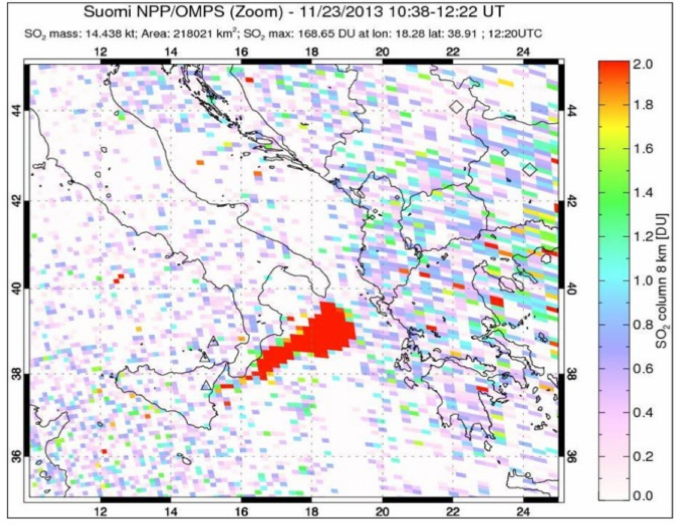
Figure 7. SO 2 retrieval from the OMPS sensor onboard the Suomi NPP platform at 12:22 UTC on 23 November 2013 (https://so2.gsfc.nasa.gov (accessed on 5 May 2021). The modeled hourly map at 12:00 UTC (same day) is reported in Figure 8a,b for run1 and run2, respectively. Two important points should be remarked: (i) the volcanic plume at 12:00 UTC for run1 is fragmented into two parts with the farthest portion already passed over the Albanian coast and (ii) the spatial pattern relative to run2 is very similar to OMPS retrievals at the same